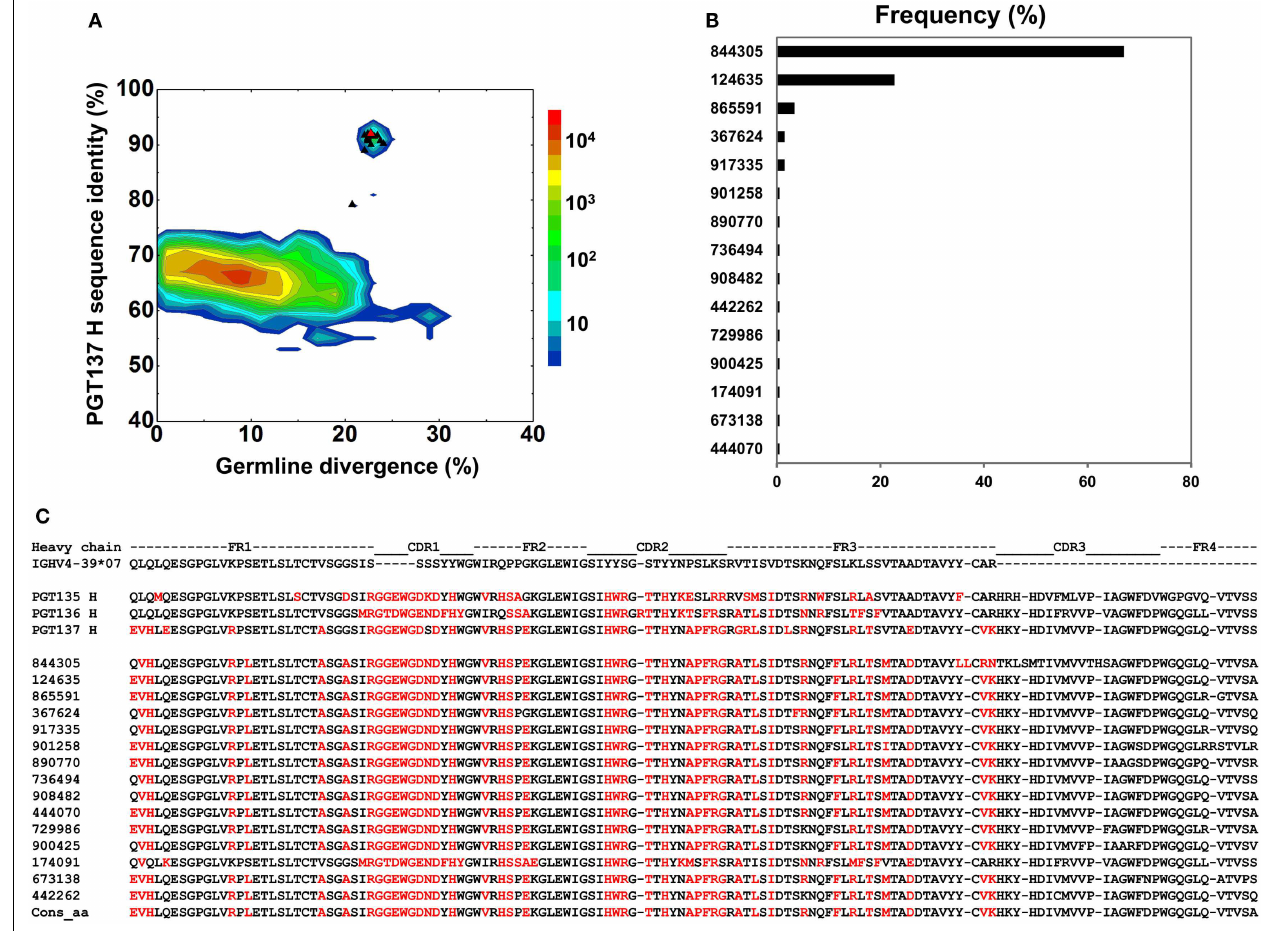
FIGURE 4 | Sequence selection for functional characterization of heavy chains from donor 39. (A) Divergence/identity analysis of 15 heavy-chain variable-domain sequences obtained from the clustering analysis of 202 sequences identified by intra-donor phylogenetic analysis. Sequences of IGHV4-39 origin are plotted as a function of sequence identity to PGT137 heavy chain and sequence divergence from inferred germline allele, with 15 selected sequences shown as black triangles and their amino-acid consensus as red triangle. (B) Percent population of 15 clusters obtained using a